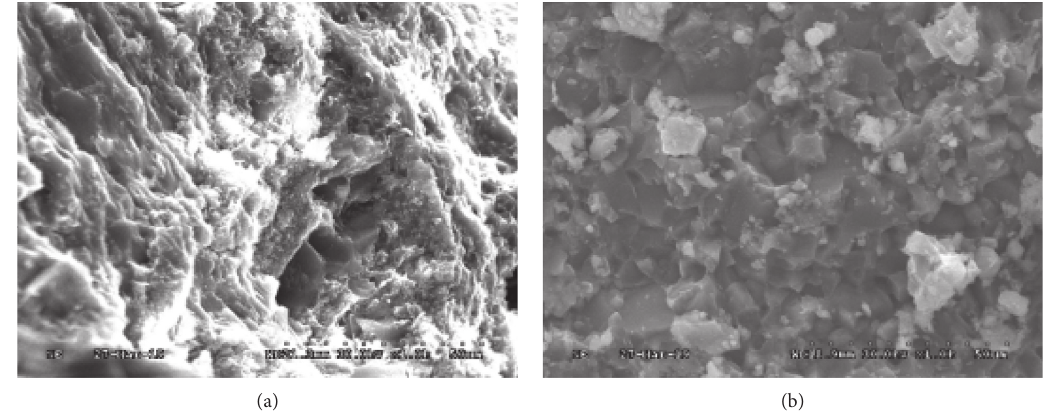
Figure 12: SEM image of coal gangue and limestone. (a) Microstructure of coal gangue. (b) Microstructure of gravels.